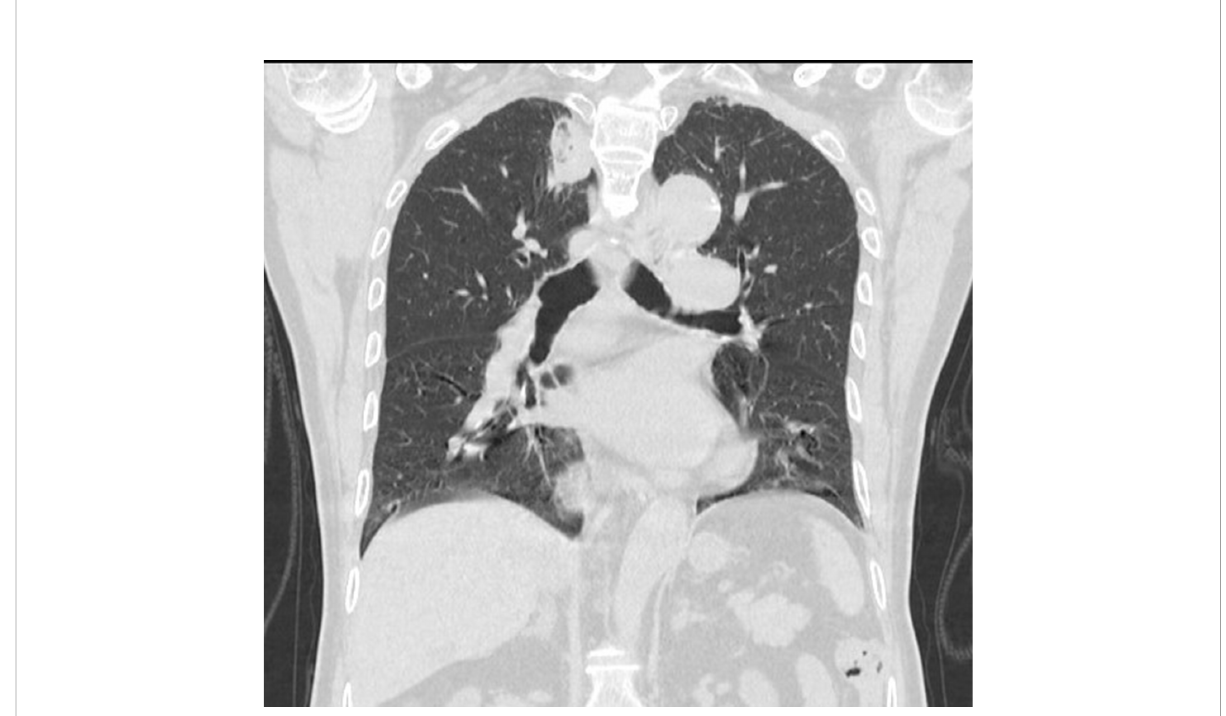
FIGURE 12 Coronal image:Follow-up after 1 month found that the lesions were completely ablated, and no tumor lesions remained or